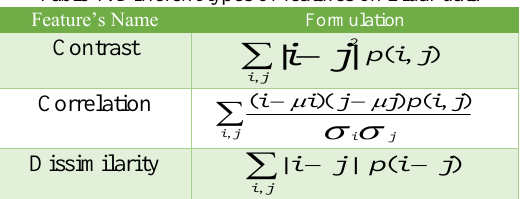
Table 1. Different types of features on Lidar data